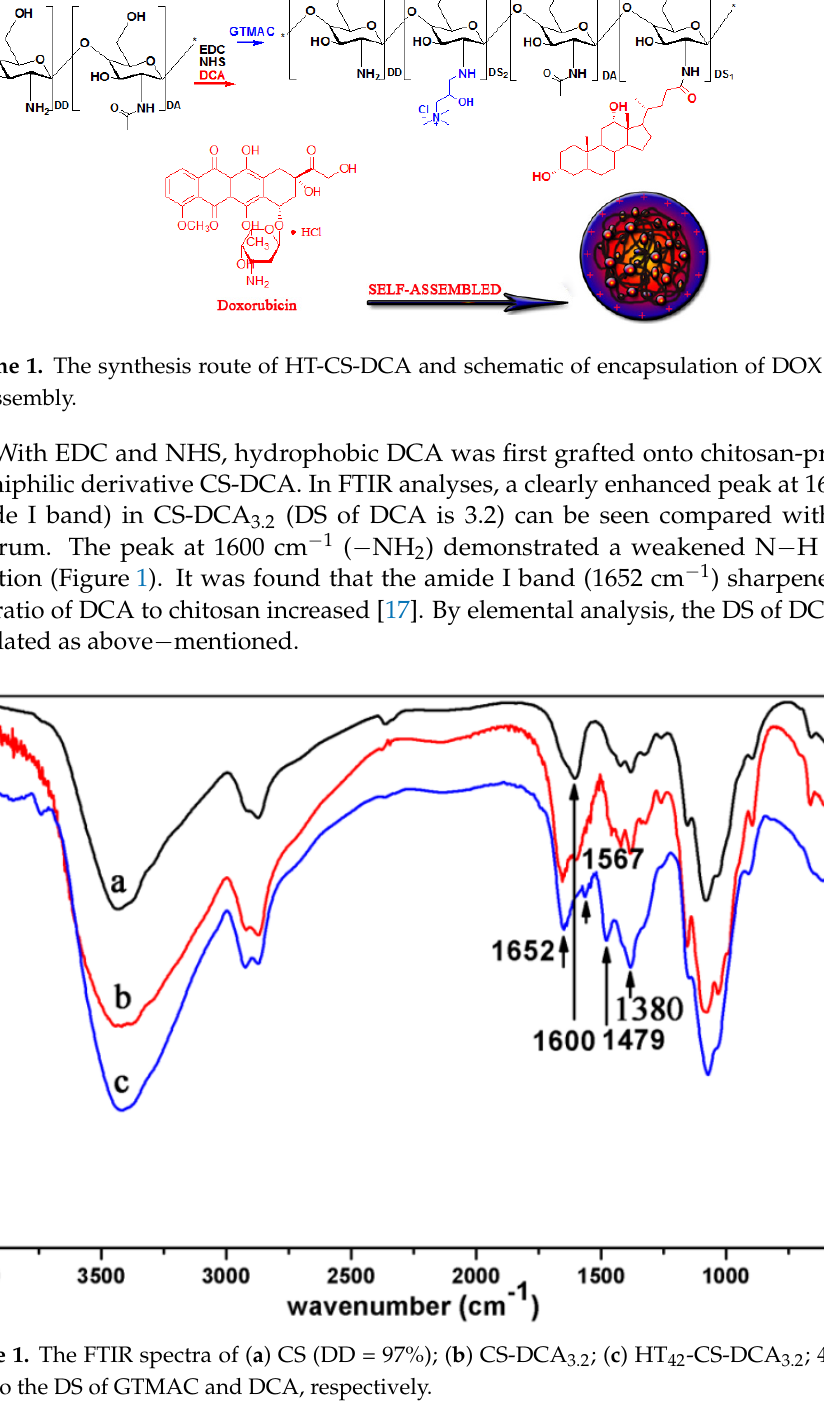
Figure 1. The FTIR spectra of ( a ) CS (DD = 97%); ( b ) CS-DCA 3.2 ; ( c ) HT 42 -CS-DCA 3.2 ; 42 and 3.2 refer to the DS of GTMAC and DCA, respectively.